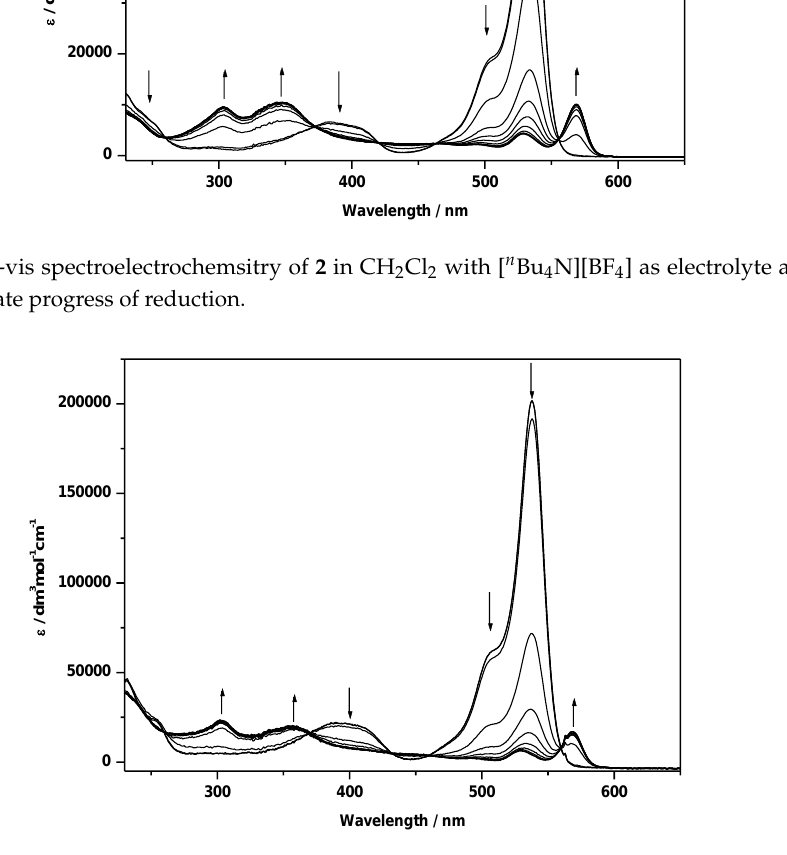
Figure 6. UV-vis spectroelectrochemsitry of 3 in CH 2 Cl 2 with [ n Bu 4 N][BF 4 ] as electrolyte at 243 K. Arrows indicate progress of